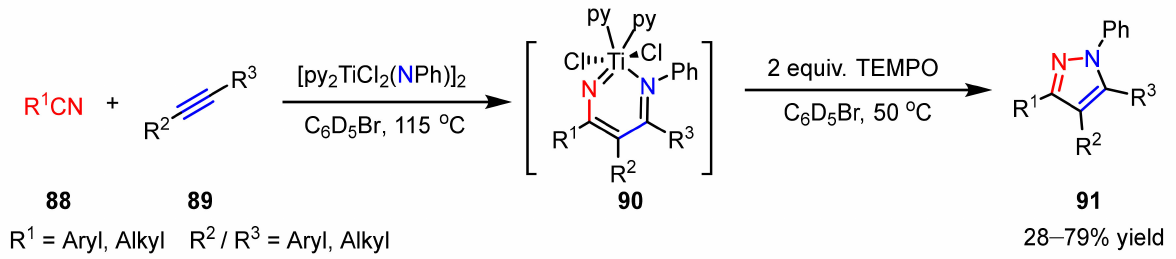
Scheme 33. Organotitanium intermediates for pyrazole